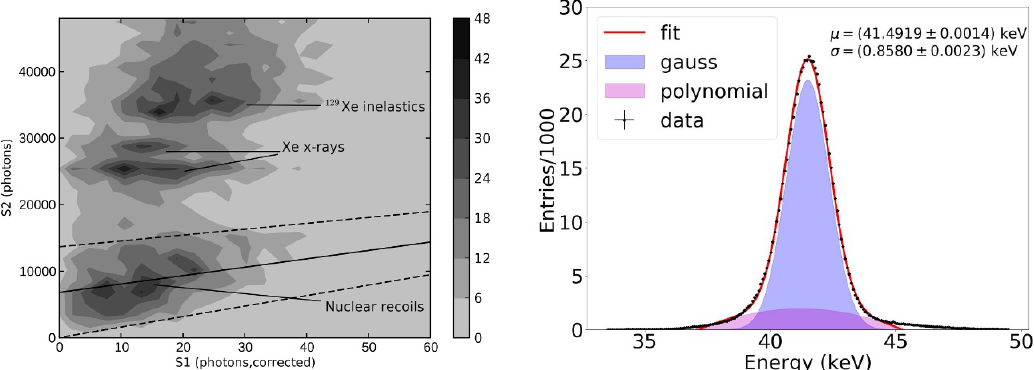
Figure 9 . Left: nuclear recoil identi(cid:12)cation in a gaseous xenon detector by using S1/S2 discrim- ination [104]. Right: example of energy resolution obtained for 41.5 keV gammas [105]. The very small Fano factor in xenon gas, two orders of magnitude lower than for liquid xenon, allows for excellent energy resolution even in large-scale detectors